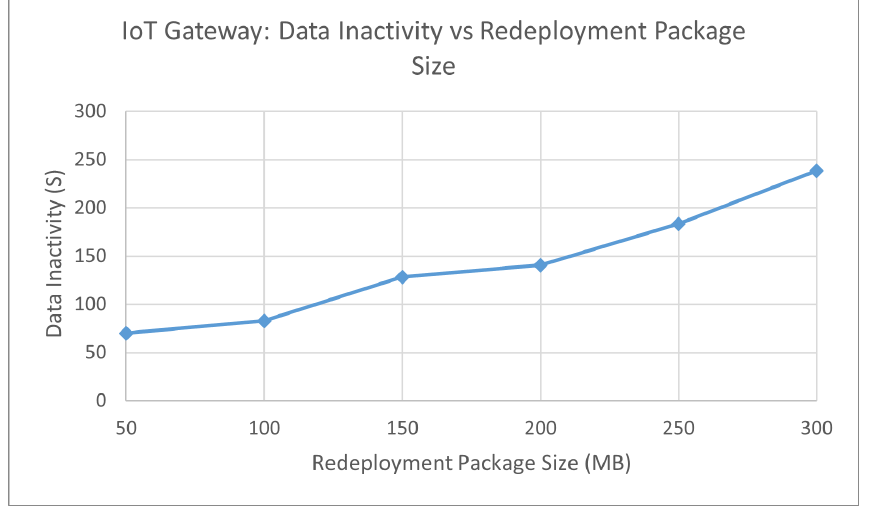
Figure 10. Data Inactivity vs. Redeployment Package